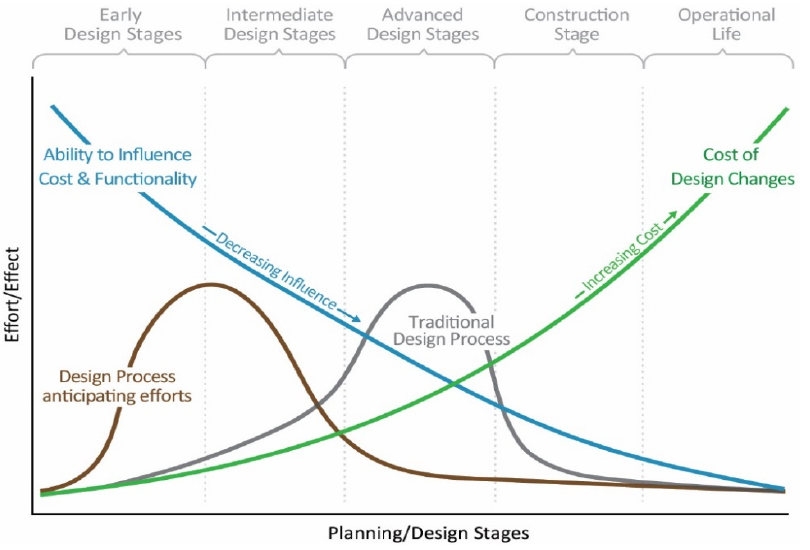
Figure 1. The MacLeamy curve (see [40,44]) for a detailed description). It illustrates the increasing cost of modifications in projects as the design/planning process progresses. cost of modifications in projects as the design/planning process